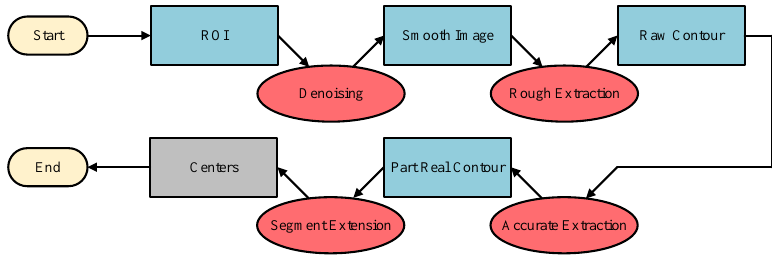
Figure 9. Flowchart of the accurate